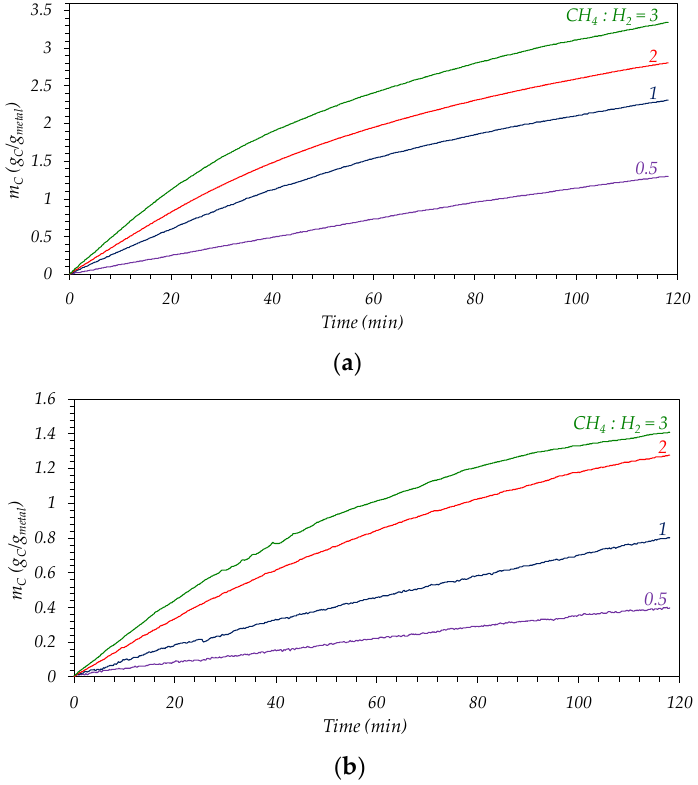
Figure 7. Influence of CH 4 /H 2 feed-ratio on the evolution of carbon concentration along time: ( a ) Ni–Cu/ArDC; ( b ) Co–Cu/ArDC. Table 3. Influence of CH 4 /H 2 feed-ratio on the initial reaction rate and carbon productivity.